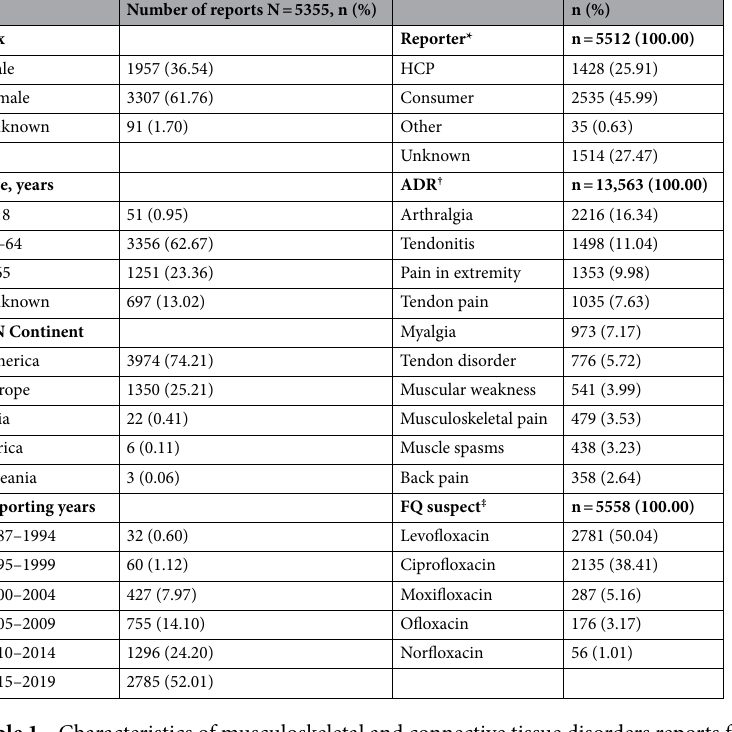
Table 1. Characteristics of musculoskeletal and connective tissue disorders reports for fluoroquinolones. FQ fluoroquinolone; HCP healthcare professional; N total number of reports; n: number of reports in a given category; UN Continent: Continent of the primary source, according to the United nations. *More than one reporter could be mentioned per individual case; † More than one ADR could be reported per individual case; Data presented for the first 10 ADRs. ‡ More than one FQ could be reported per individual case; Data presented for the first 5 FQs.